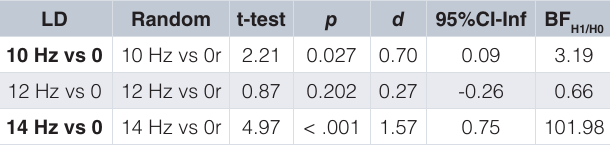
Table 7. Inferential statistics and parameters estimation of the comparison of the percentage of correct classification of the periods of stimulation and non-stimulation between the linear discriminant and the random classifier in the non-stimulated